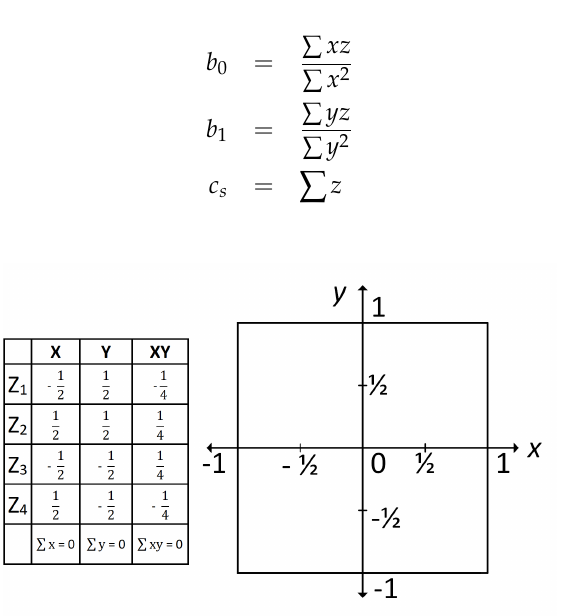
Figure 3. Aggregation results of x , y and xy is zero due to